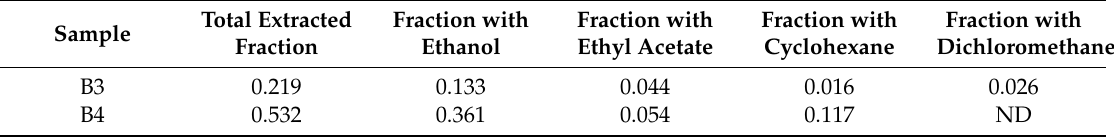
Table 2. Weight fraction extracted with each organic solvent evaluated. B3: Coil 3; B4: Coil 4. Total Extracted Fraction with Fraction with Fraction with Fraction Sample Fraction Ethanol Ethyl Acetate Cyclohexane